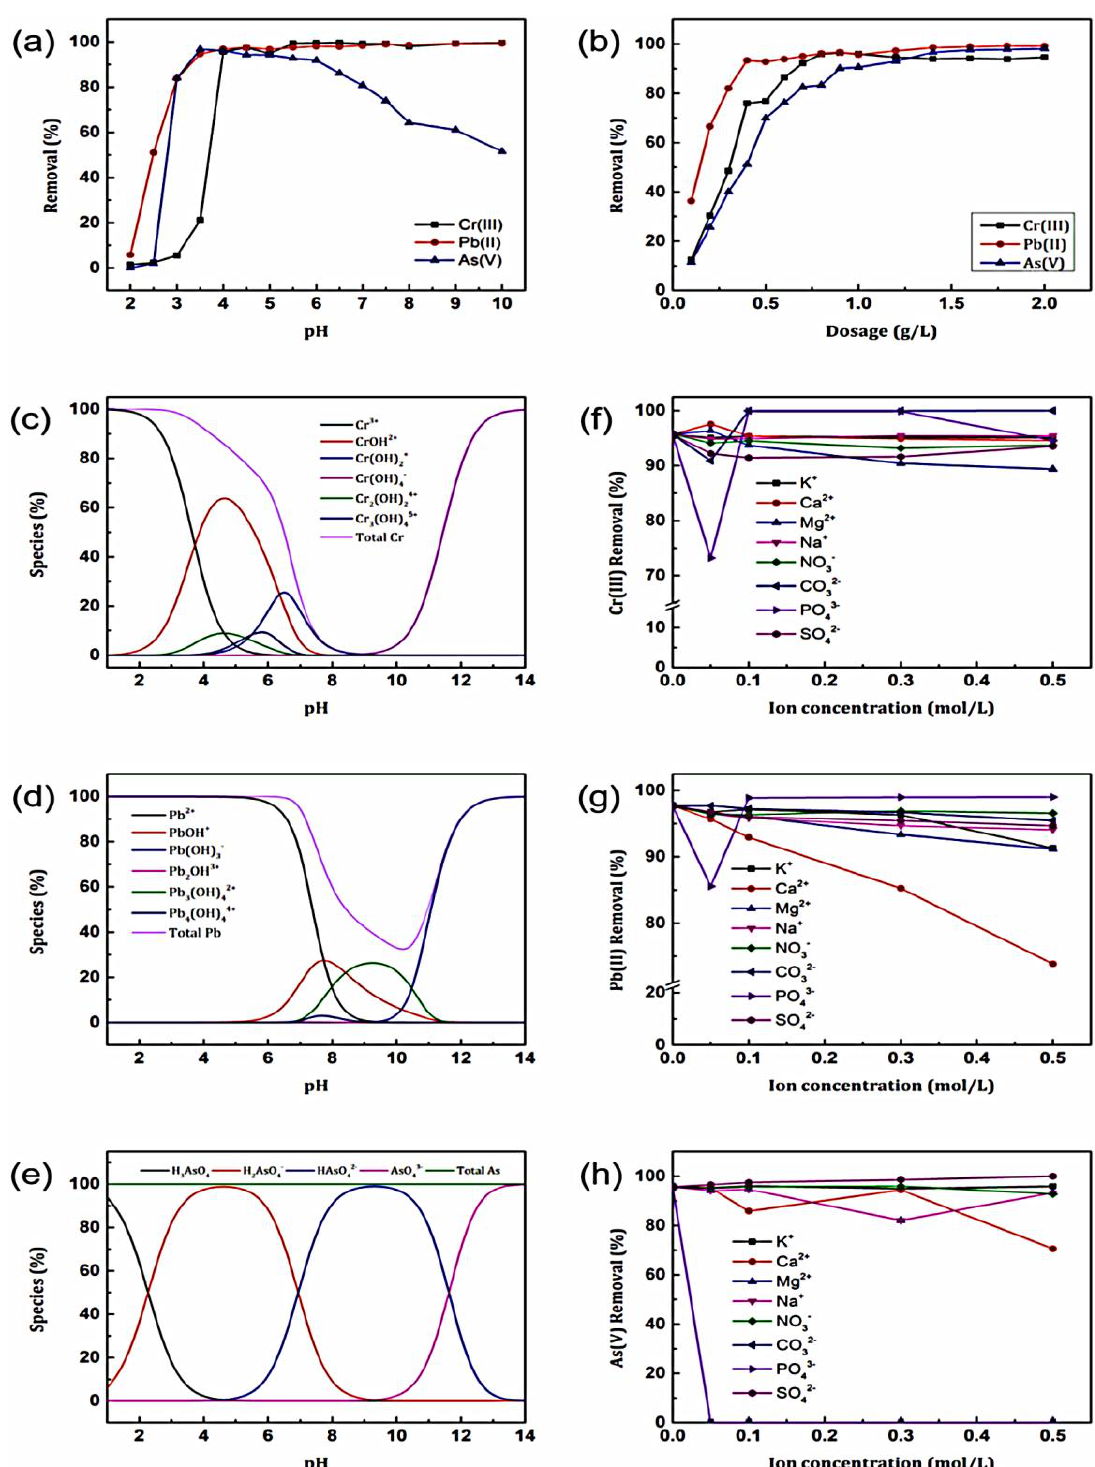
Figure 8. The effect of ( a ) pH and ( b ) dosage of the corresponding metal ions. Graphs of fractions versus ph for: ( c ) Cr(III), ( d ) Pb(II), ( e ) AS(v). Influence of the ion species on the removal of the metal ions: ( f ) Cr(III), ( g ) Pb(II) and ( h ) As(V) [83]. (Adapted with permission from ref. [83]. Copyright 2022 Elsevier.)